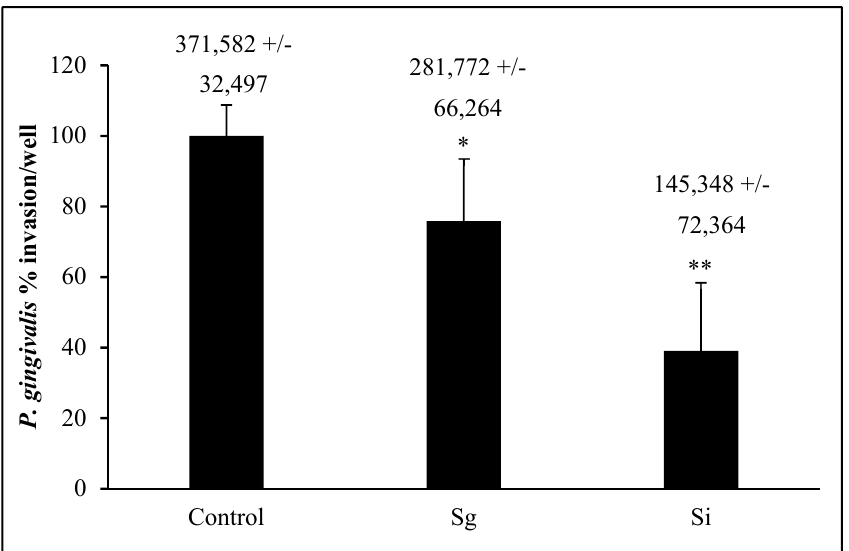
Figure 5. Invasion of P. gingivalis following exposure to commensal bacteria. Percentage of P. gingivalis CFUs (absolute values +/ − SD above each bar) that invaded OKF6 / Tert cells after exposure to S. gordonii (Sg) or S. intermedius (Si). All bacteria were added to OKF6 / Tert cells at MOI = 100. Graph represents the average and SD of four independent experiments. * = p < 0.05 compared to control. ** = p < 0.05 compared to control and Sg.